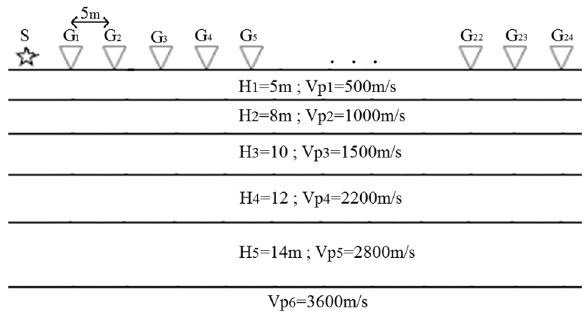
Fig. 3 Section of a six-layer model (model B) and the geometry of applied array ( S shot, G geophone)